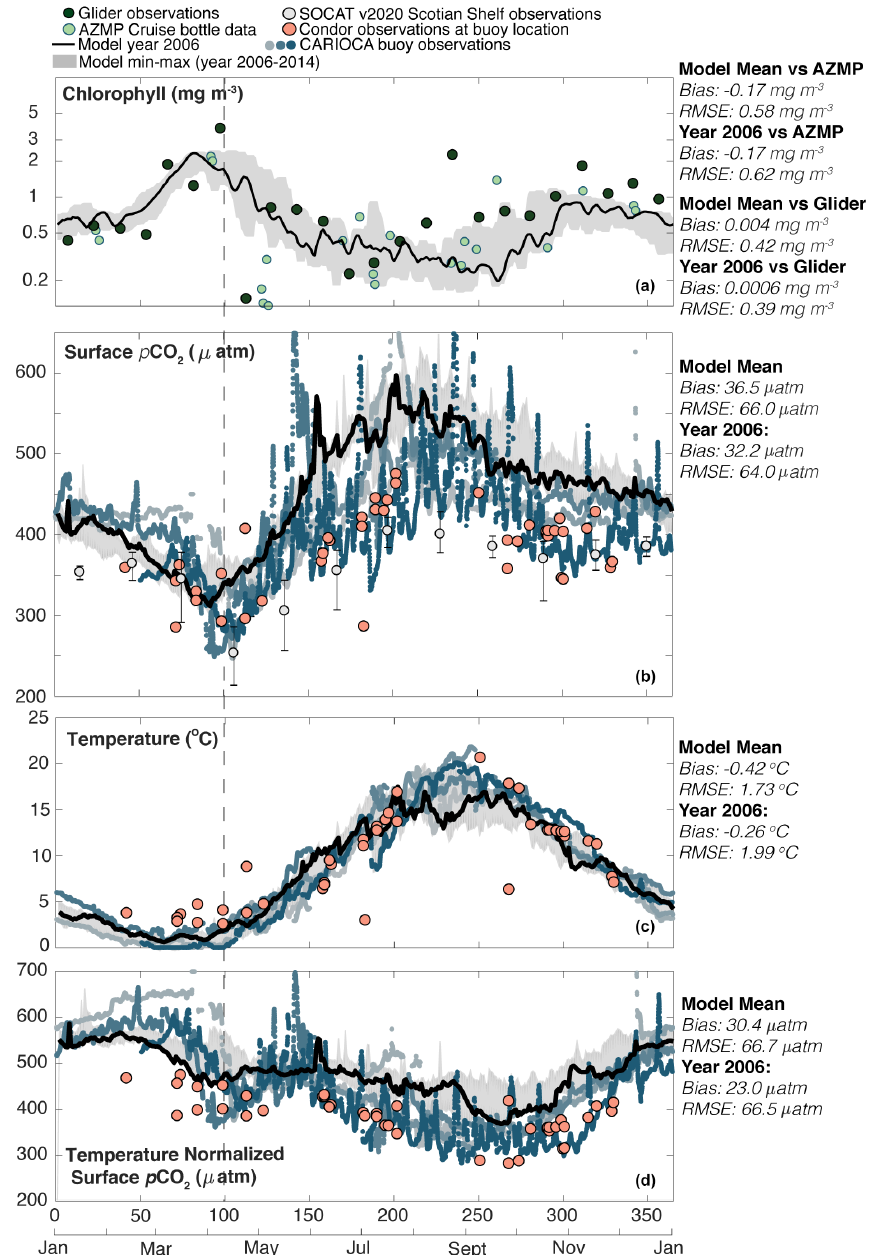
Figure 2. Seasonal (from panel a to d , with RMSE and bias in reference to year 2006) (a) chlorophyll (glider RMSE: 0.39mgm − 3 , glider bias: 0.0006mgm − 3 ; AZMP RMSE: 0.62mgm − 3 , AZMP bias: − 0 . 17mgm − 3 ); (b) p CO 2 (RMSE: 64.0µatm, bias: 32.2µatm); (c) tem- perature (RMSE: 1.99 ◦ C, bias: − 0 . 26 ◦ C); (d) temperature-normalized p CO 2 following Takahashi et al. (2002) (RMSE: 66.5µatm, bias: 23.0µatm) at Station 2 on the Scotian Shelf. The model year 2006 is shown with the thick black line and min–max in the model from years 2006–2014 with the grey shaded area in all panels. In panel (a) the dark green points are AZMP bottle data and light green points are glider data. In panels (b) – (d) observations from the moored CARIOCA buoy are shown as small blue points, with lighter shades of blue indicating earlier observations and darker shades indicating more recent observations, and observations from the Atlantic Condor transects at approxi- mately the same location as the buoy are shown in large pink points. Both the Atlantic Condor and CARIOCA buoy observations are mapped to year 2006 using the atmospheric trend in p CO 2 . Light grey points are monthly mean SOCAT observations for the entire Scotian Shelf, and the error bars are the 10th and 90th